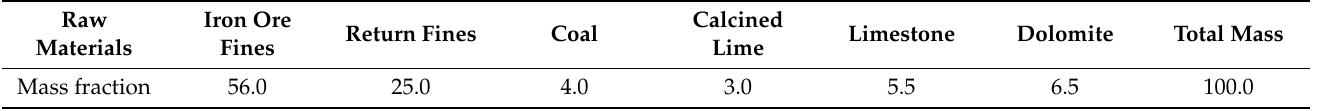
Table 5. Composition of sintering